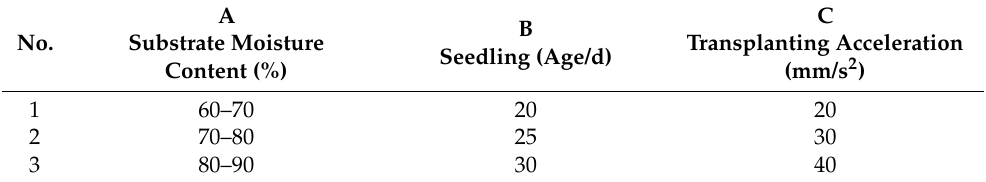
Table 1. Parameters of the orthogonal